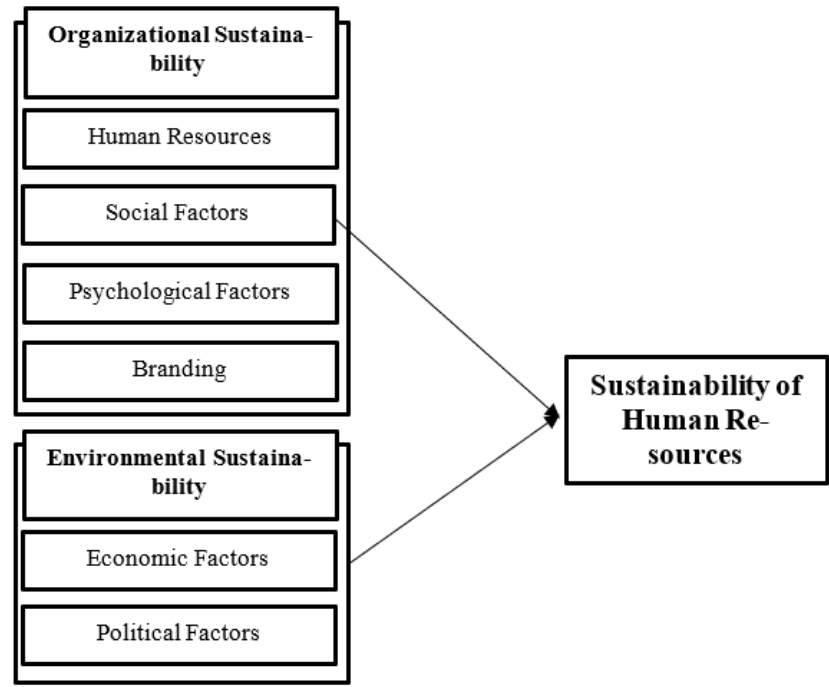
Figure 1. Conceptual model (Source: Authors’